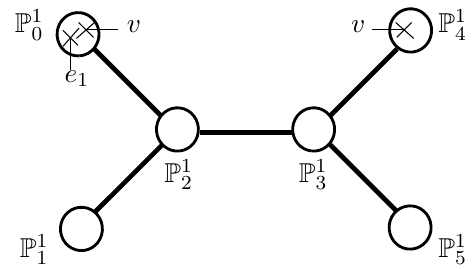
Figure 3 . The extended Dynkin diagram of SO(10) obtained from intersections of divisors D I